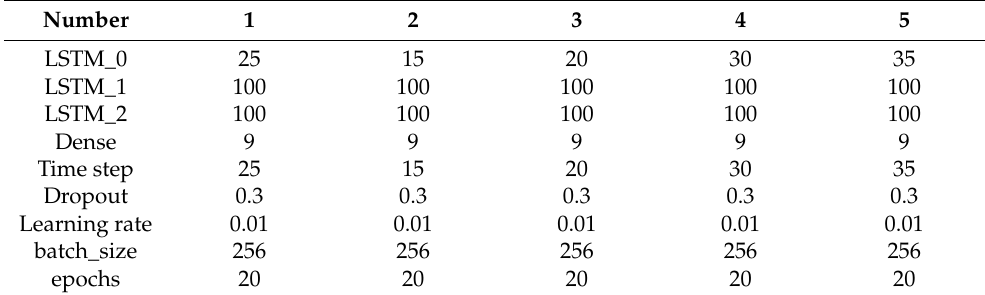
Table 8. Neural network parameters of working condition